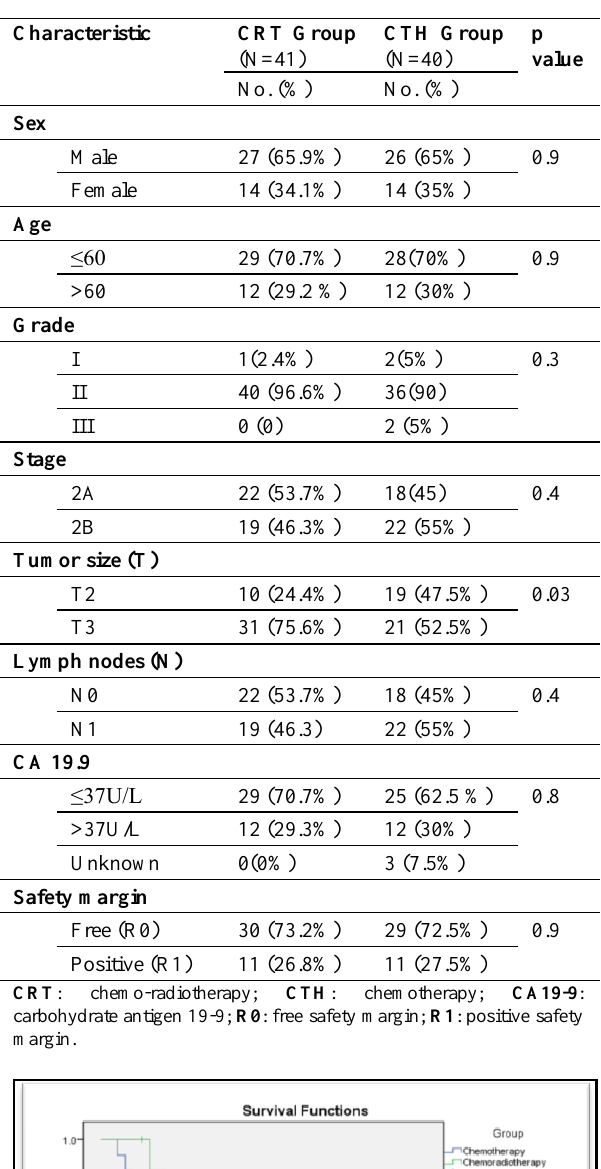
Table 1: Patients’ characteristics